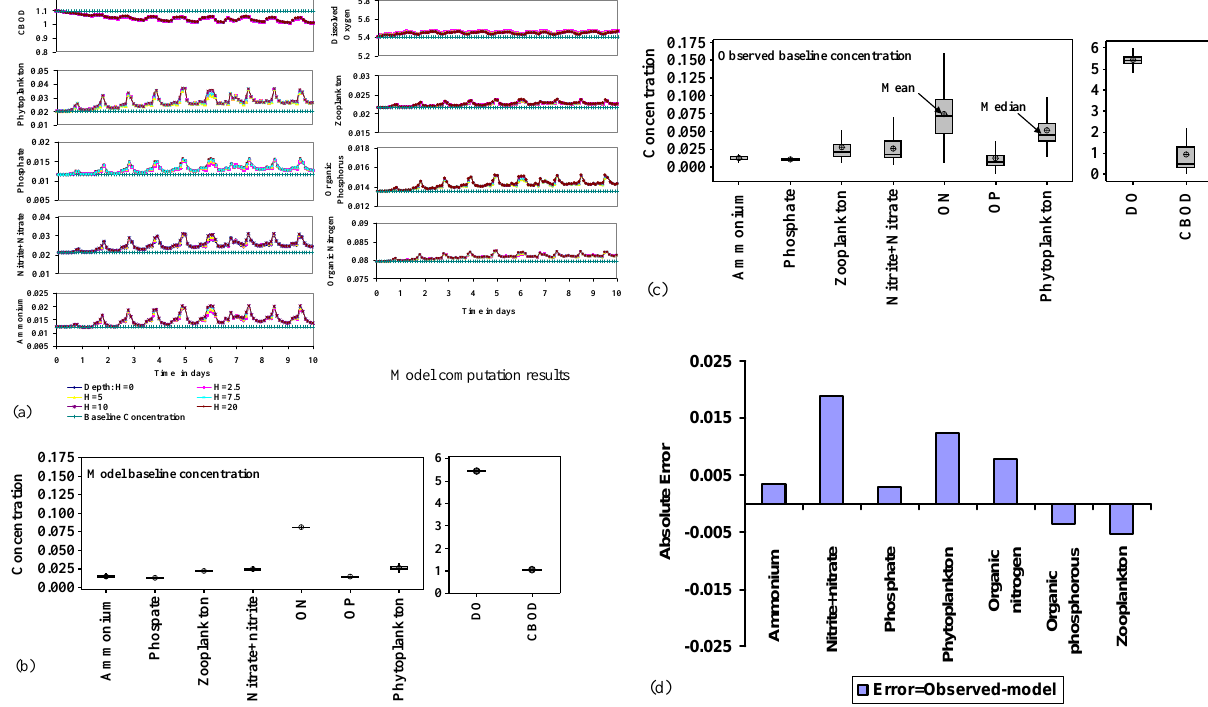
Fig. 3. Comparison of computed and measured baseline concentrations. (a) Computed time-1096 series of baseline concentrations at a monitoring station ”SS” on the South Coast of 1097 Singapore; (b) box-plots of computed baseline concentrations; (c) observed baseline 1098 concentration in the domain (Tkalich and Sundarambal, 2003; Sundarambal, 2009b); (d) 1099 absolute error diagram of model state variables between computed model results and field 1100 observations for 24-hours hindcast at a monitoring station “JS”. Note: Parameters (Units): 1101 Ammonium (mg/l), nitrate-nitrogen (mg/l), phosphate (mg/l), phytoplankton (mgC/l), 1102